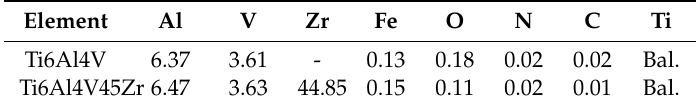
Table 1. Chemical composition of the as-received Ti–6Al–4V and Ti–6Al–4V–45Zr (wt.%). Element Al V Zr